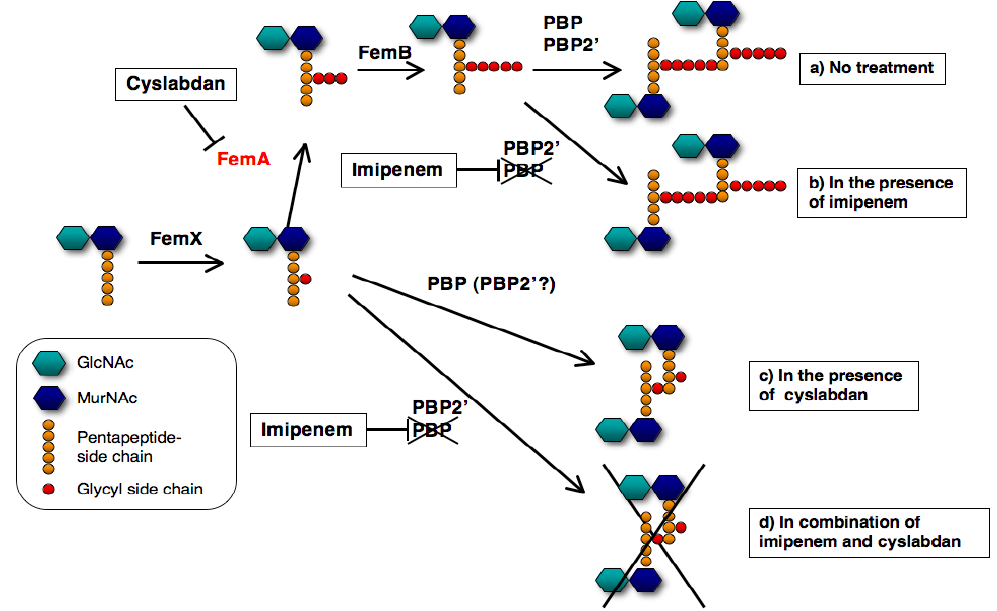
Figure 9. Proposed mechanism underlying the effect of cyslabdan on the activity of imipenem against MRSA. The following four cases are shown here: ( a ) no treatment ( b ) in the presence of imipenem, ( c ) in the presence of cyslabdan and ( d ) combination of imipenem and